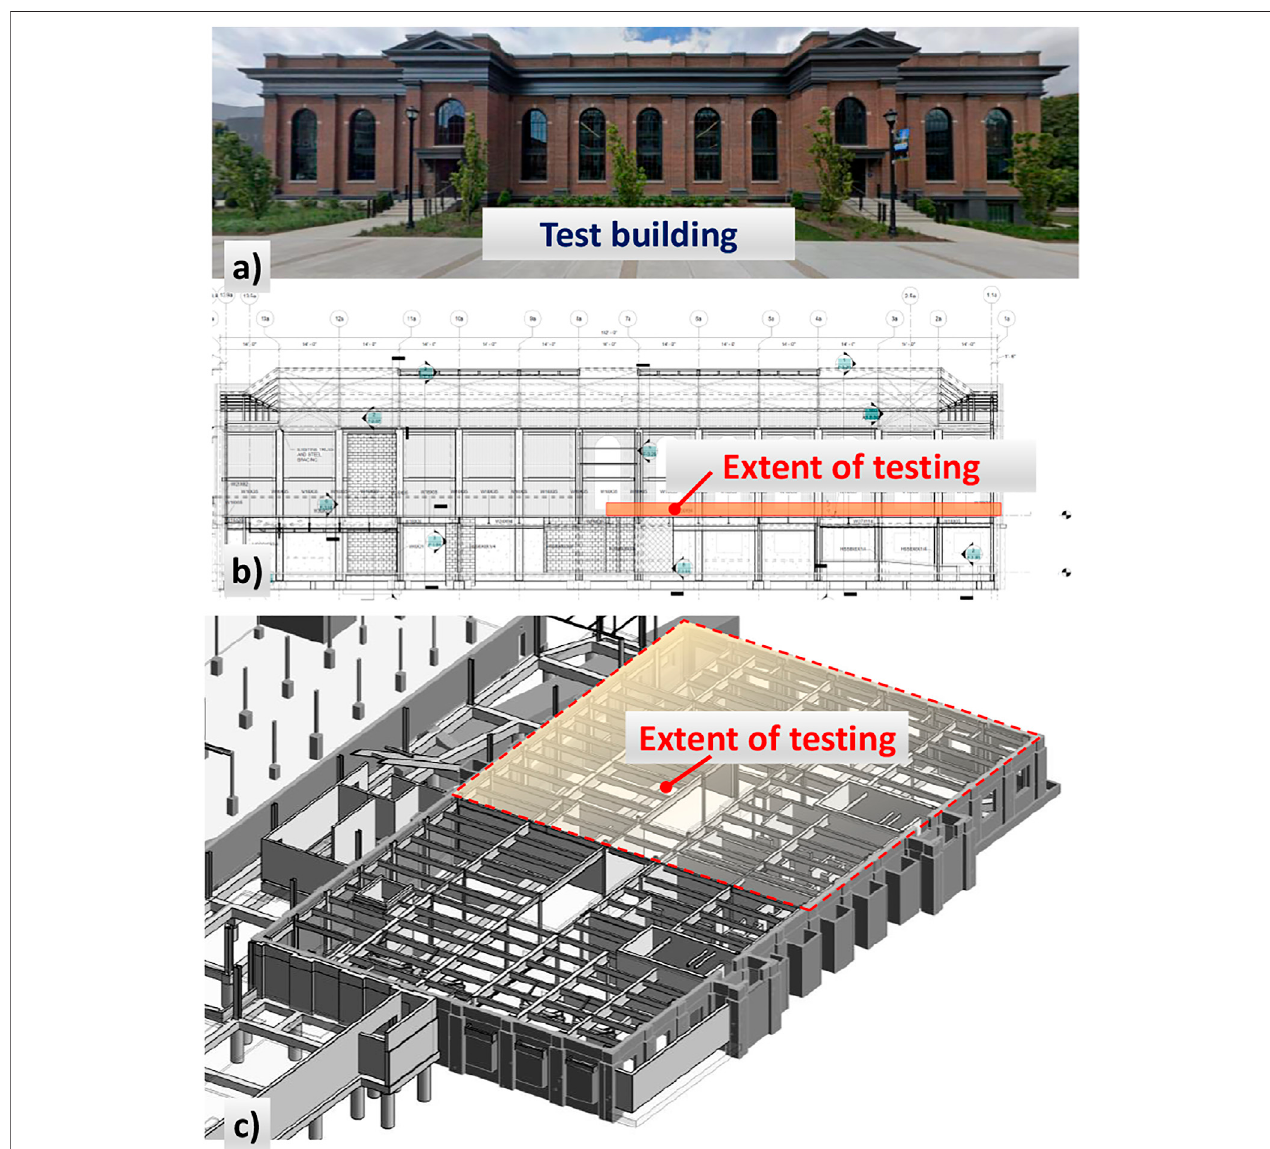
FIGURE 1 | The test building and extent of